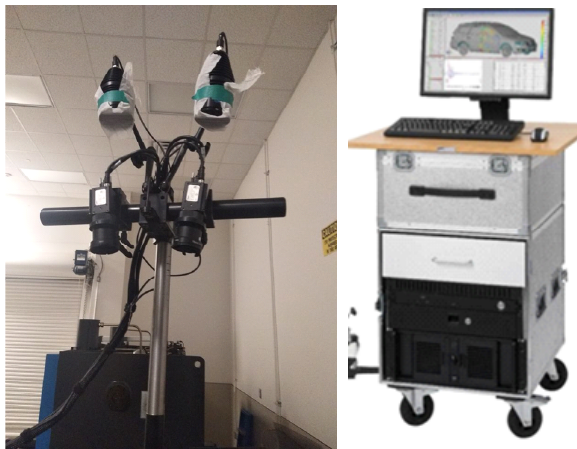
Figure 2. Camera and data processing system of ARAMIS.